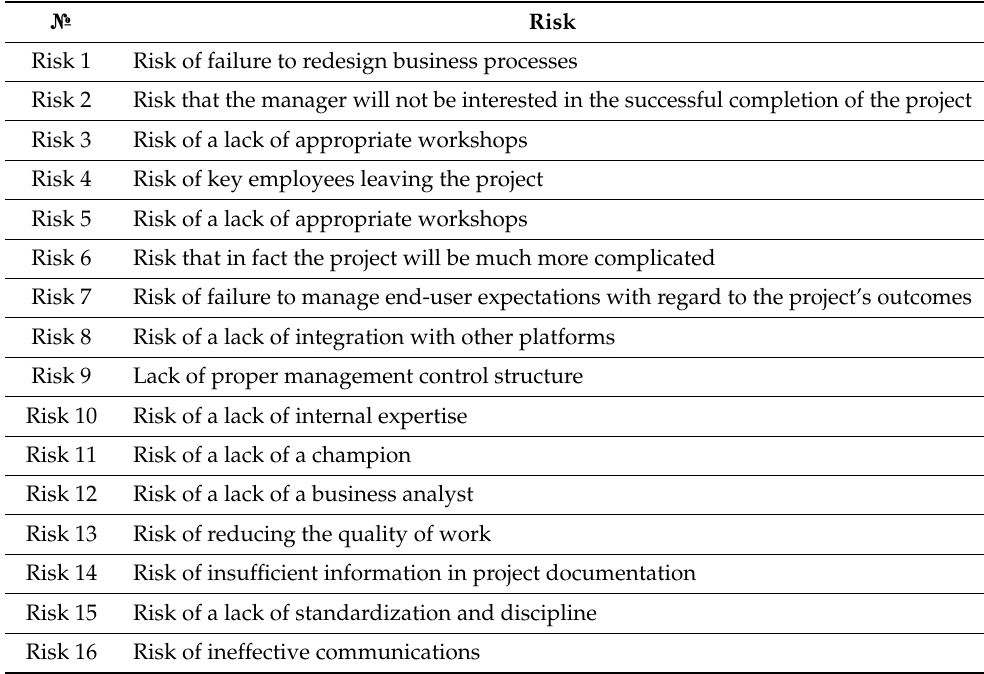
Table 10. List of current IT project risks according to Sumner M. research